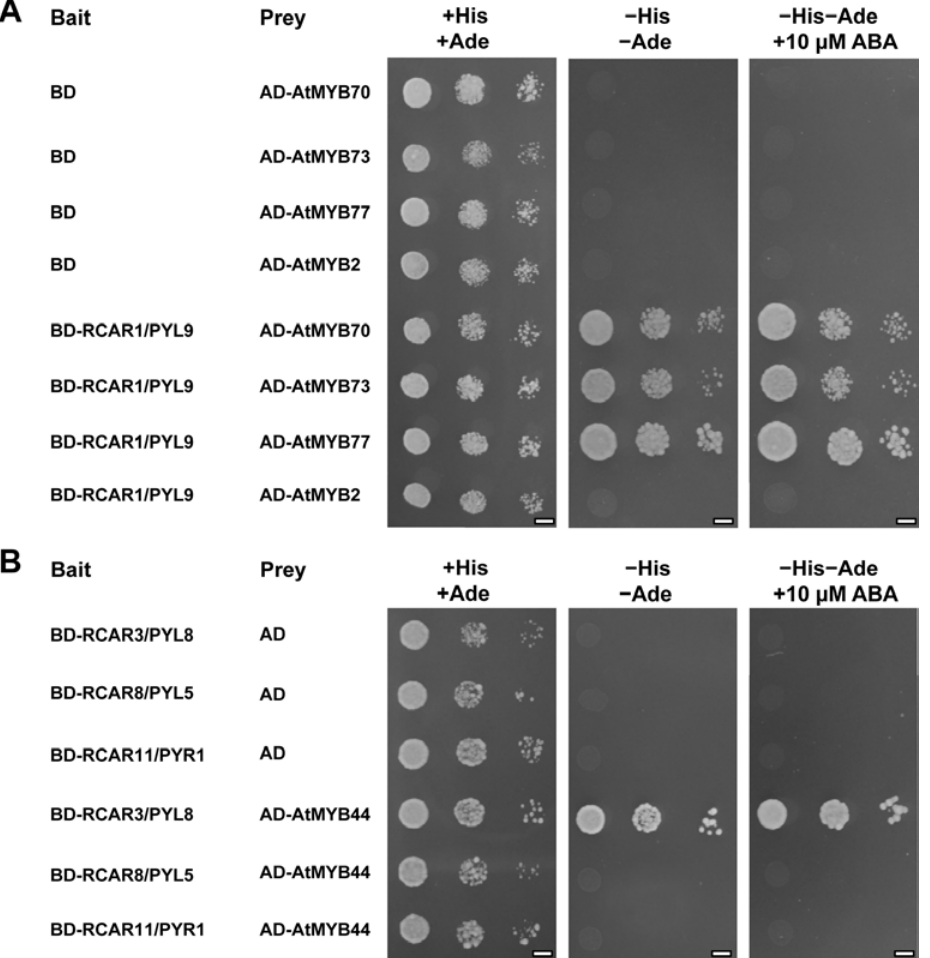
Figure 2. Interactions between RCARs/PYR1/PYLs and the other members of 22nd subgroup of R2R3-MYBs. ( A ) Yeast two-hybrid assay was performed using RCAR1/PYL9 as bait and the full-length AtMYB70, AtMYB73, and AtMYB77 and AtMYB2 as preys. The empty BD and prey vectors were used as negative controls. Picture of the plates were taken after 3 days at 30 °C; and ( B ) Yeast two-hybrid assay was performed using the full-length RCAR3/PYL8, RCAR8/PYL5 and RCAR11/PYR1 as baits and AtMYB44 as prey. The empty AD and bait vectors were used as negative